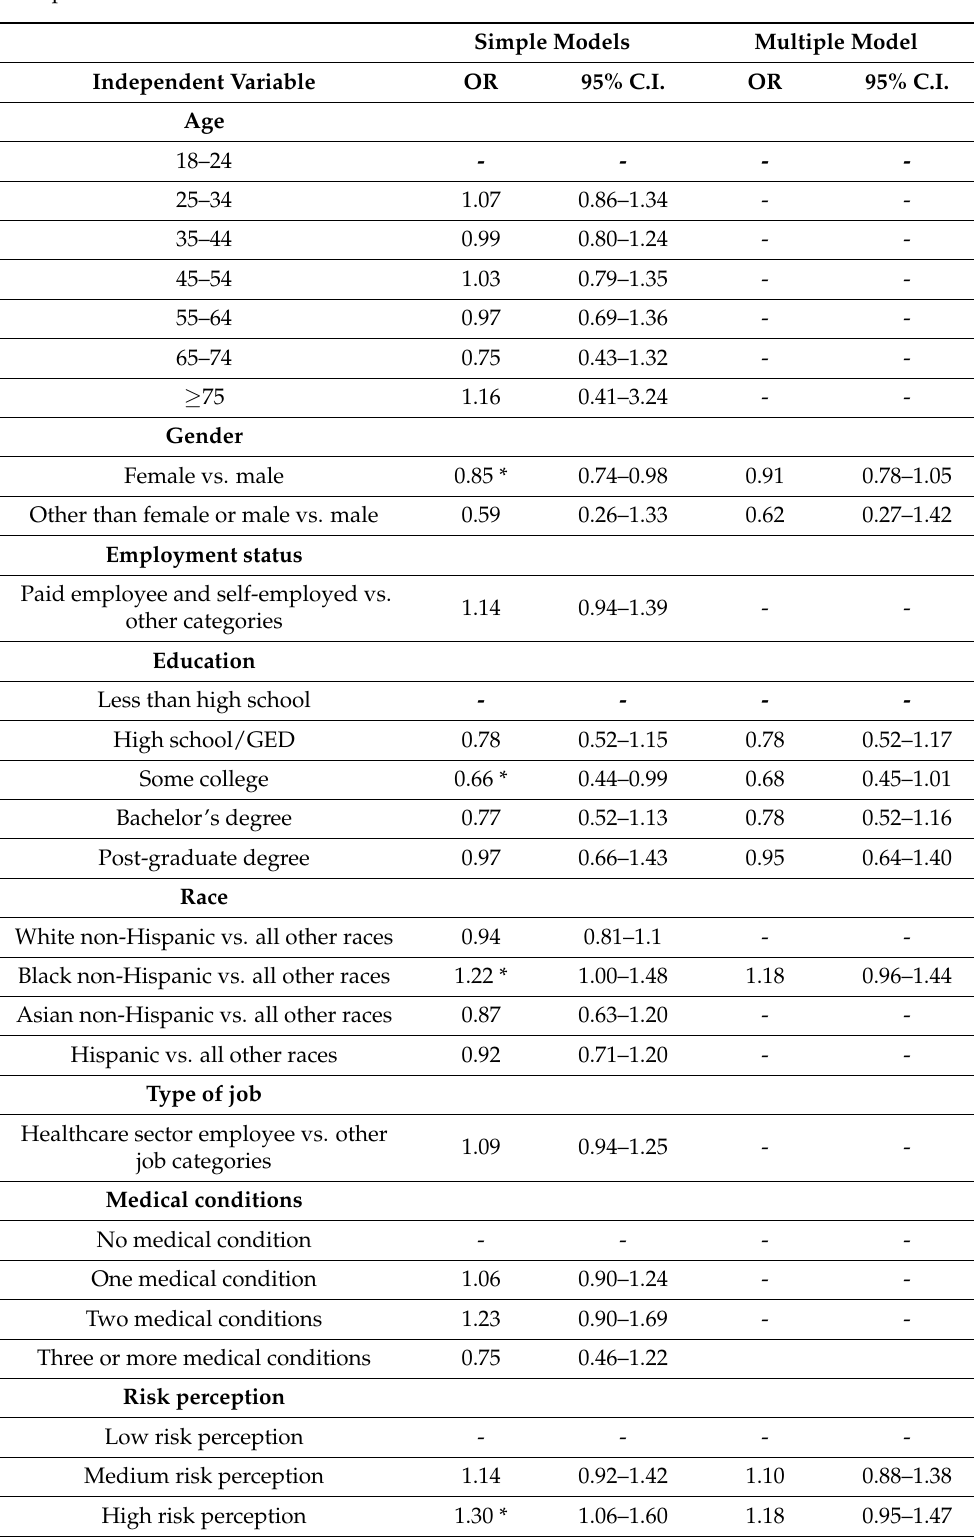
Table 3. Association between independent variables and vaccine hesitancy: simple models and multiple variable